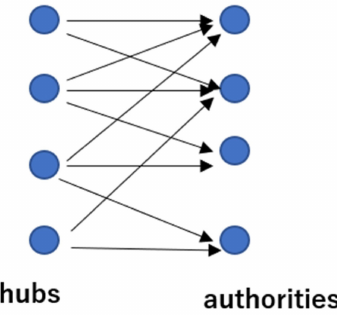
Figure 2. Densely linked set of hubs and